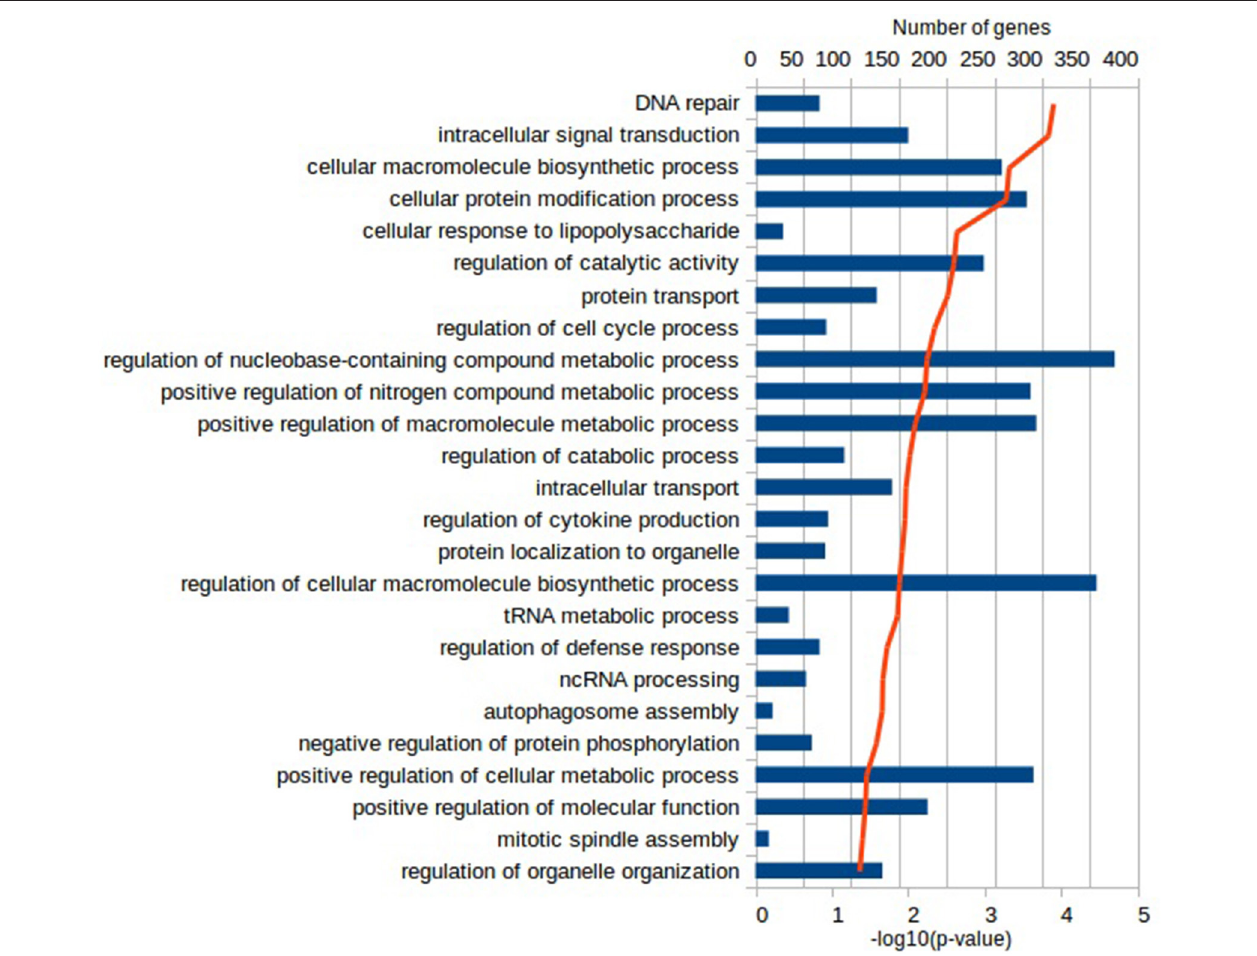
FIGURE 2 | The most enriched GO terms in the Biological Process ontology in the Vac Tf vs. Vac T0 comparison in PANTHER with the Fisher’s exact test and Benjamini-Hochberg False Discovery Rate correction. The blue bars depict the number of genes in the enriched terms, while the red line the adjusted- p -values.